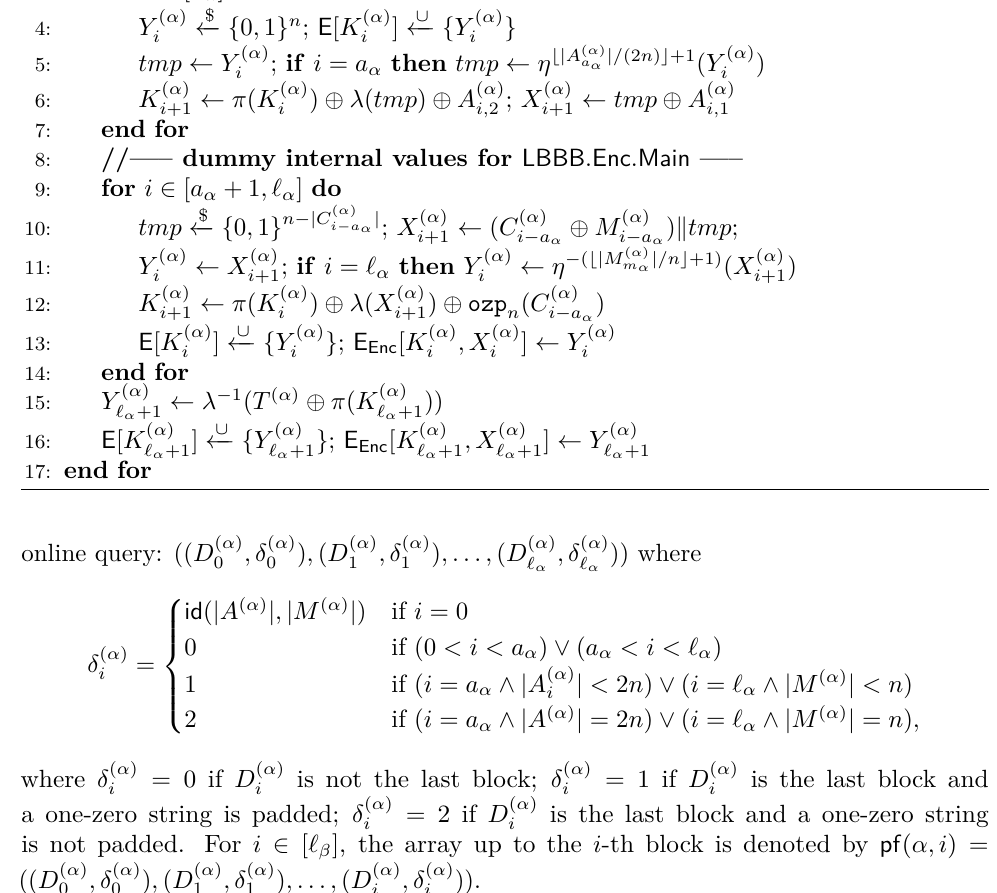
Algorithm 2 defines a dummy key K , dummy outputs Y ( α )